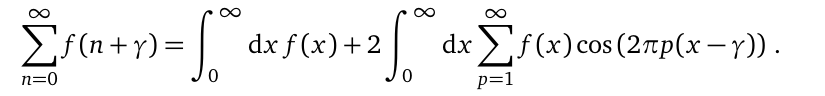
Figure 1: An example band structure of the sort we consider. The solid lines show the energies E ± in Eq. (2), while the dashed lines show ε c k prior to hybridization. We have indicated the offset energy ε 2 g , and marked in red the point on the lower band where the gap is minimized. Inset: a 3D view of the bands. The area traced by the minimum gap, setting the QO frequency, is indicated with the red dashed